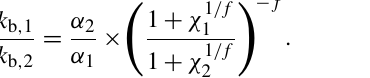
Figure 1. Bubble-mediated gas exchange rate ( K b ) normalized to that of argon. Temperature was at 20 ◦ C. Contours are equivalent to K b , Ar /K b , 2 , where K b , 2 varies as a function of solubility and Schmidt number. At low solubilities ( α , Ostwald solubility coeffi- cient), scaling among gases depends only on variation of Schmidt number (SF 6 ). As solubility increases, scaling depends on both Schmidt number and α (CO 2 ). O 2 is similar to Ar. Propane has similar properties to SF 6 . Analysis is based on Eq. (13) in Woolf et al.